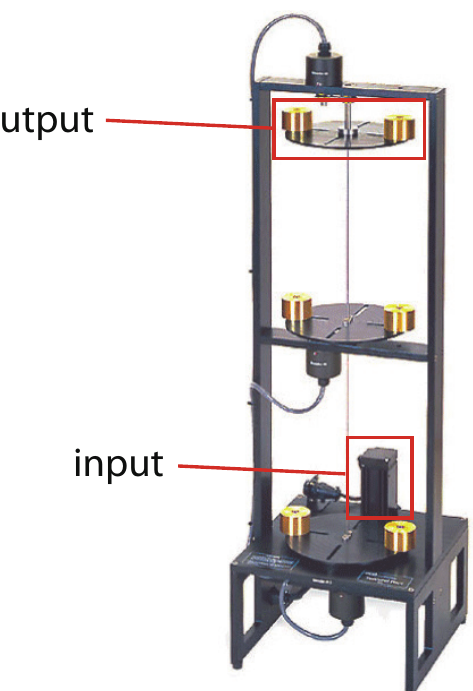
Figure 8. The ECP 205 torsional system.